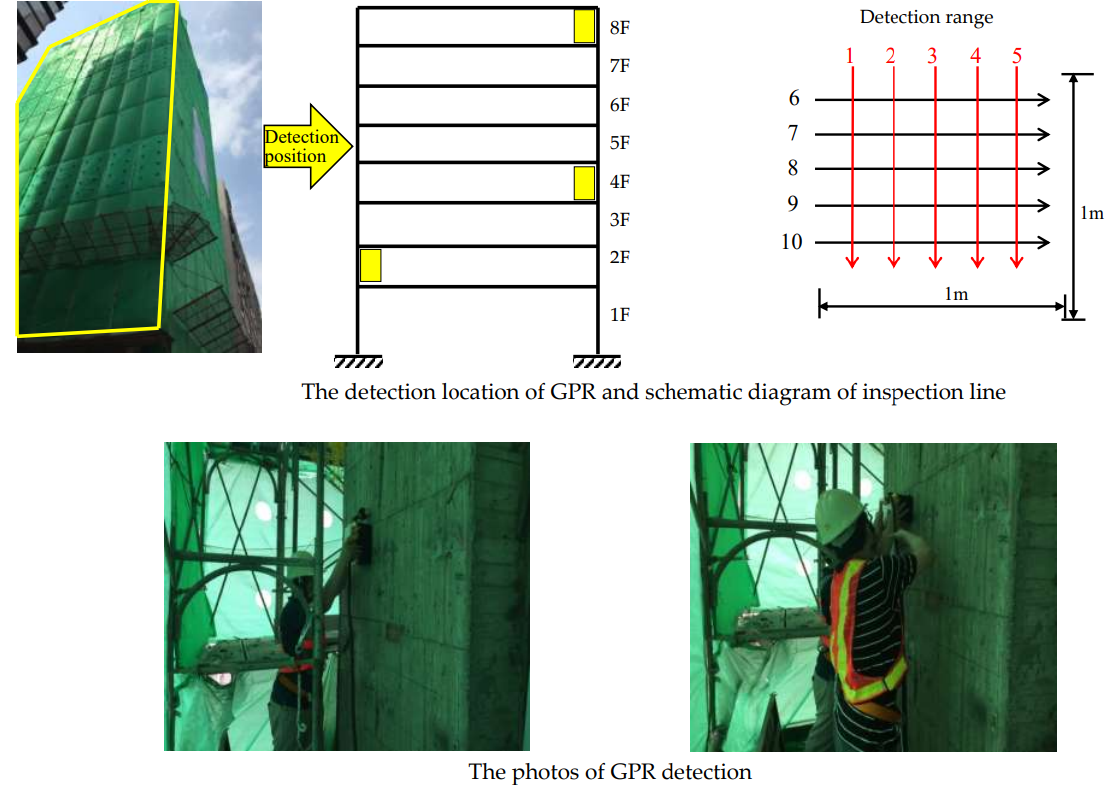
Figure 21. Building Corrosion Inspection.